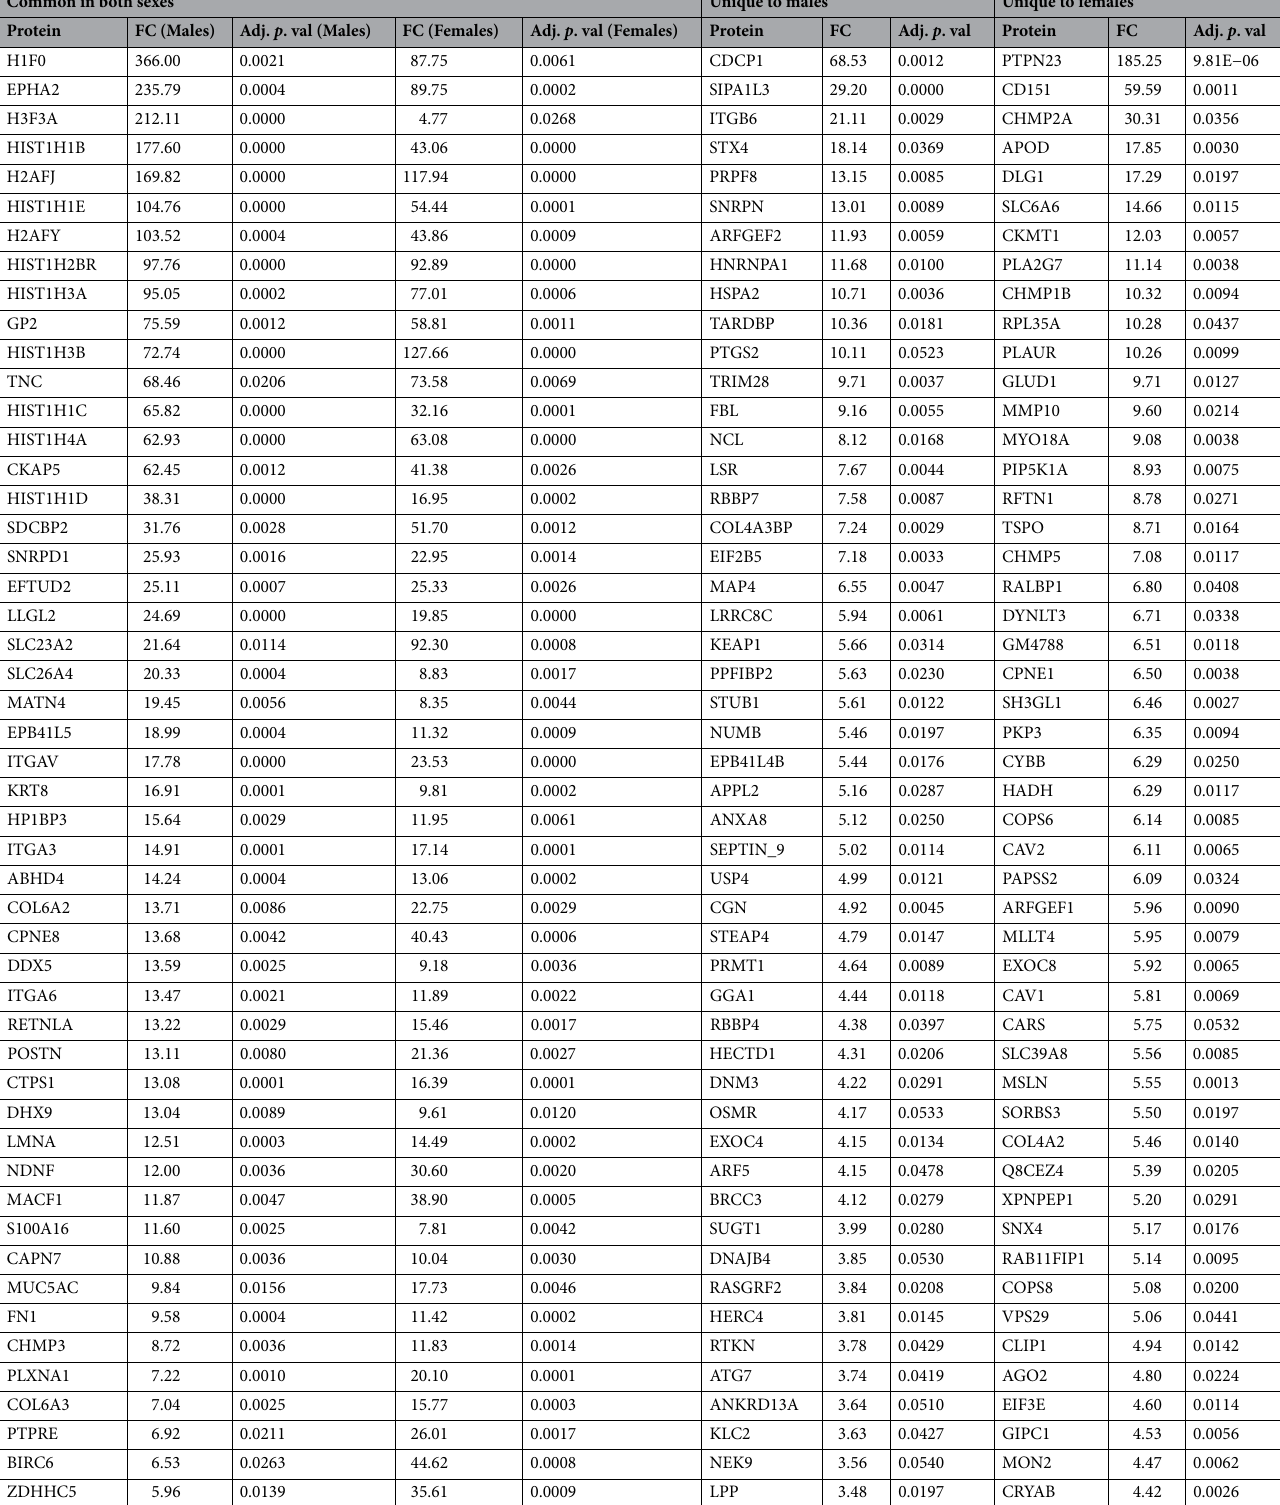
Table 3. Top 50 protein signatures that were enriched in ozone-exposed mice versus air-exposed